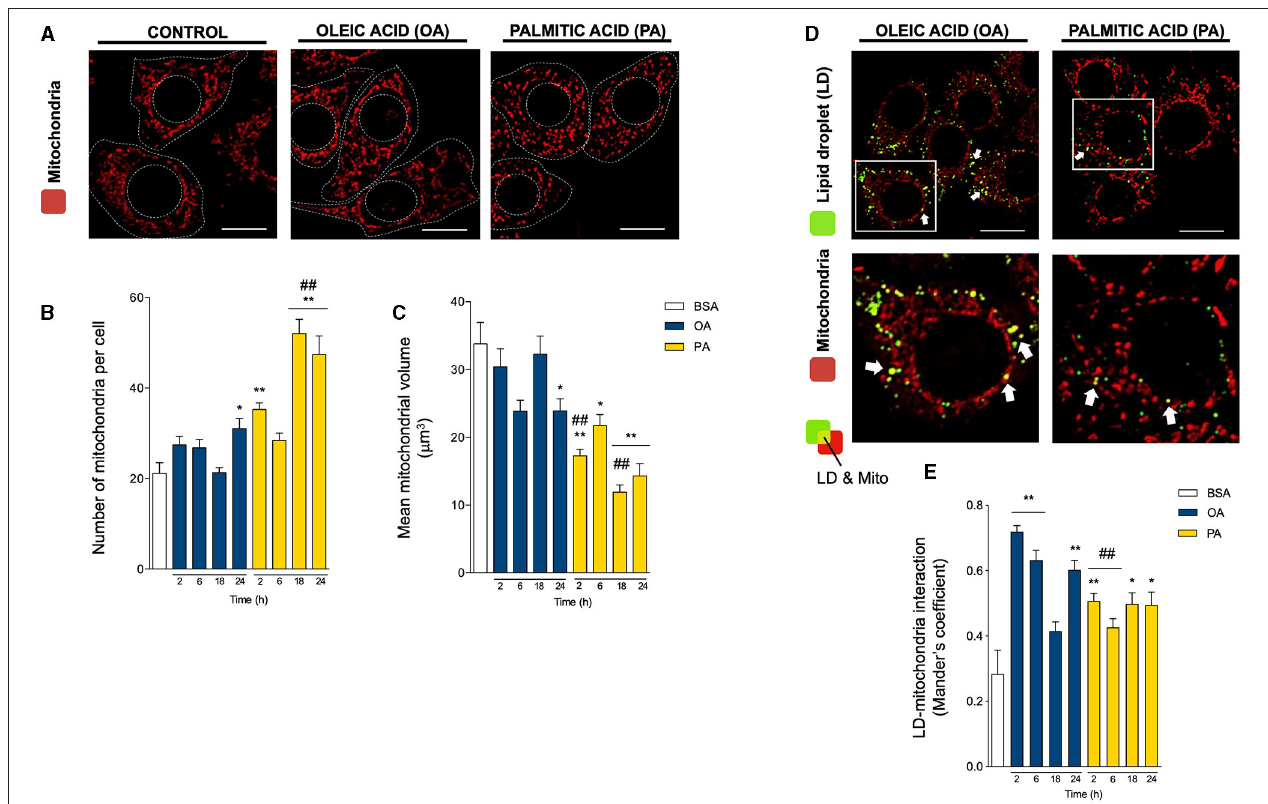
FIGURE 2 | Oleic and palmitic acids differentially remodel mitochondrial morphology and their interaction with lipid droplets in HepG2 cells. (A) Representative confocal imaging of HepG2 cells treated with 200 µ M of oleic acid (OA) or palmitic acid (PA) during 18h and stained with MitoTracker Orange (red) for mitochondria visualization. Segmented lines represent the cellular and nuclear contours. Scale bar: 10 µ m. (B) Quantification of the number of mitochondria per cell in images treated as in A for 0–24h. (C) Mean individual mitochondrial volume of HepG2 cells treated as in A for 0–24h. (D) Representative merged confocal imaging of HepG2 cells treated with 200 µ M of OA or PA during 6h and stained with Bodipy 493/503 (green) and MitoTracker Orange (red) for lipid droplet (LD) and mitochondria visualization, respectively. Colocalized areas are shown in yellow. White arrow marks spots of high colocalization. Scale bar: 10 µ m. (E) Quantification of LD-mitochondria colocalization using Manders’ coefficient for cell images obtained as described in D . Data are from N = 6–20 cells analyzed from three independent experiments. Scale bar: 10 µ m. Results are shown as mean ± SEM; * p < 0.05; ** p < 0.01 vs. BSA; and ## p < 0.01 vs. OA at the same time